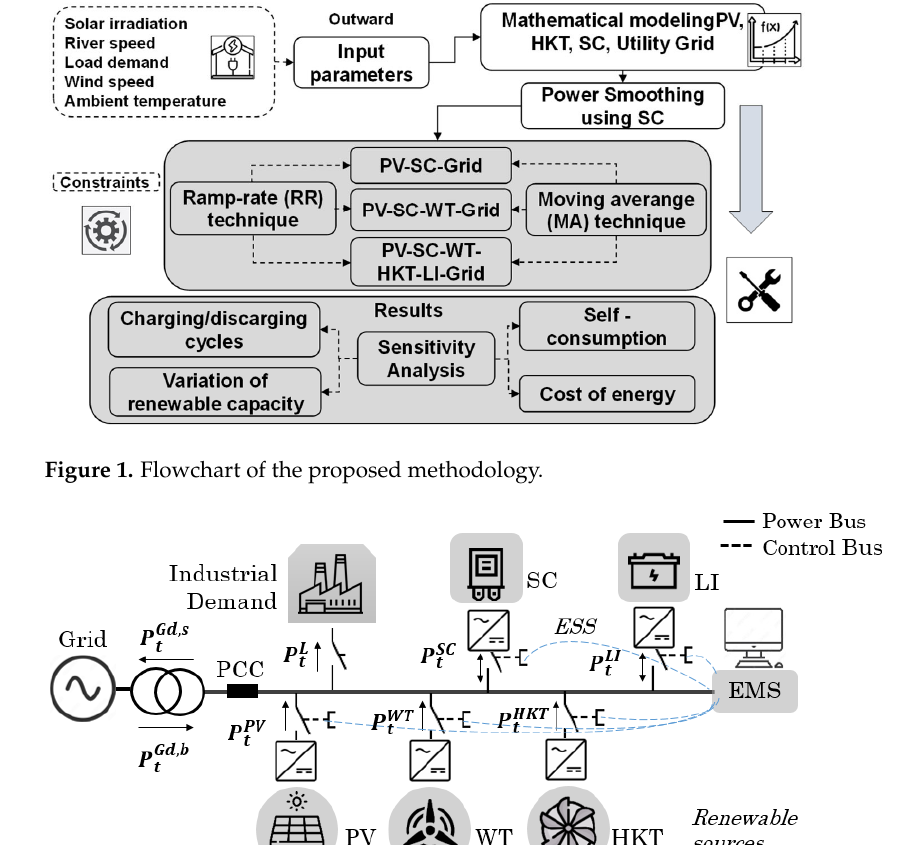
Figure 1. Flowchart of the proposed methodology.